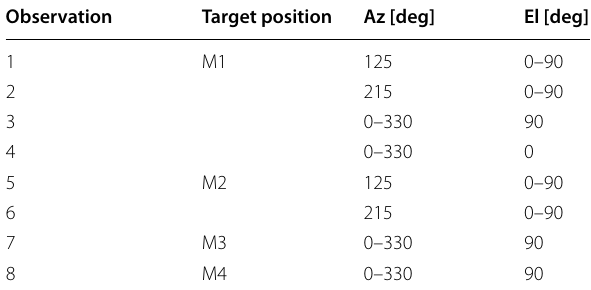
Table 2 Combination of target mirror’s positions and antenna rotation angles for inside method